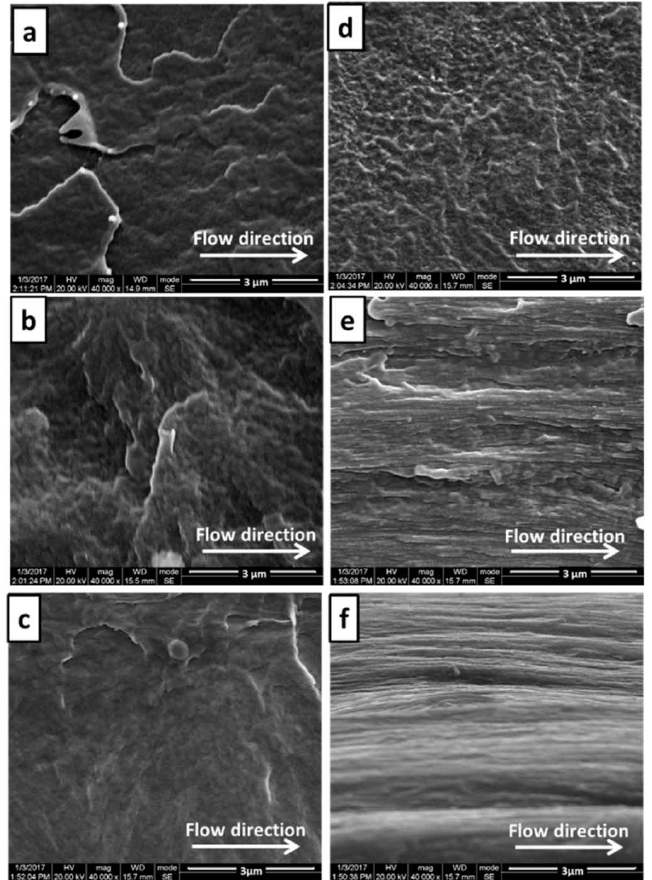
Figure 7. SEM images of the core layers and the shear layers of PVDF micro-parts at different injection speed: the core layer at 100 mm/s ( a ), 300 mm/s ( c ) and 500 mm/s ( e ); the shear layer at 100 mm/s ( b ), 300 mm/s ( d ) and 500 mm/s ( f